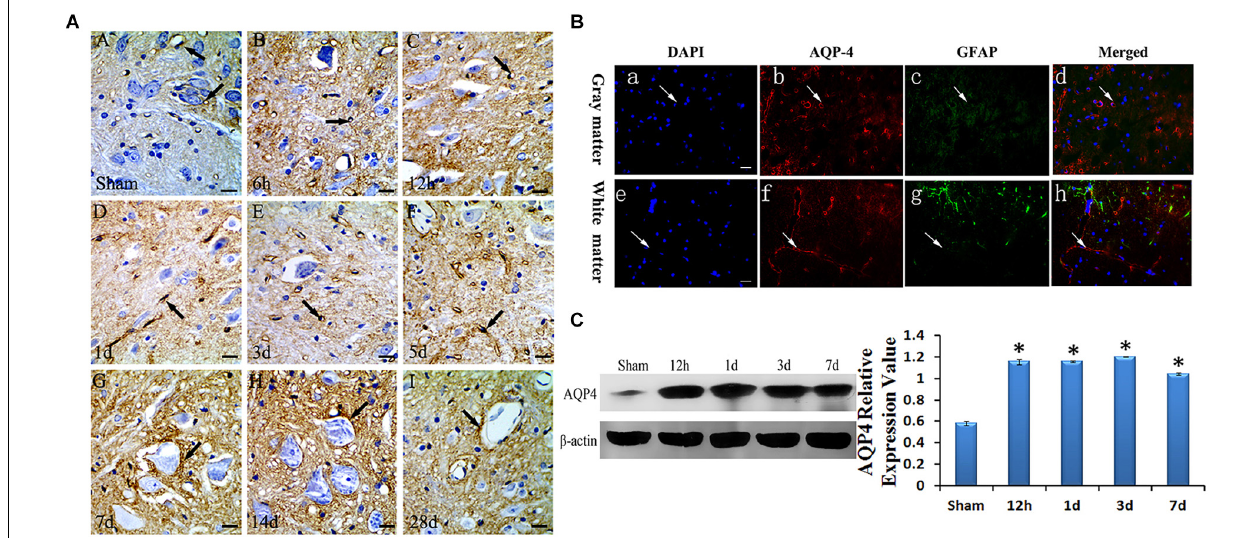
FIGURE 2 | Expression and location of AQP4 in edema after SCC. Panel (A) shows the anterior horn of spinal cord gray matter (T10). AQP4 immunoreaction was in the gray matter of the spinal cord, which was revealed to be brown, we can see AQP4 increased apparently in SCC, and reached the peak at 3 days post-SCC, then has a transitory decrease, but at 7 days post-SCC, it picked up a lot, and was restored to preoperative level, at 28 days post-SCC. ( A : sham group, showed the AQP4 within normal level. Panels (B–I) showed the AQP4 at 6 h, 12 h, 1 day, 3 days, 5 days, 7 days, 14 days and 28 days post-SCC). (B) Immunofluorescence was used to detect the distribution of AQP4 in the spinal cord at 3 days after SCC. Panels (B-a–d) show that DAPI, AQP4 and GFAP merge in the gray matter of the spinal cord. Panels (B-e–h) show that DAPI, AQP4 and GFAP merge in the white matter of spinal cord. Panels (B-a,e) show that the nucleus of cells was labeled by DAPI (blue) in the spinal cord. Panels (B-b,f) show AQP4 immunoreaction products (red). Panels (B-c,g) show that little of the GFAP immunolabeling (green) was detected in the somata and neuritis of astrocyte. AQP4 immunoreaction products (red) in the spinal cord were labeled in the VEC of gray matter. Panels (B-d,h) co-localization of DAPI (blue), AQP4 (red) and GFAP (green) are shown in the injured spinal cord, where AQP4 surrounds the VEC and in the astrocytic processes in injured spinal cords. Bar = 100 µ m. (C) The bands show the immunostaining of AQP4 and beta-actin by Western blotting. The density of the bands measured by ImageJ. Data were normalized to beta-actin. The expression of AQP4 protein was significantly increased compared sham group at 12 h, 1 day, 3 days and 7 days after SCC. ∗ P < 0.05 when compared to the sham group ( n = 8).